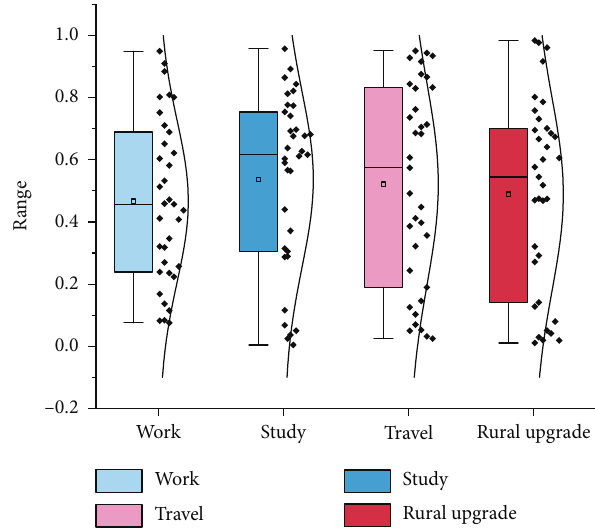
Figure 6: The application status of multimedia technology in various industries from 2000 to